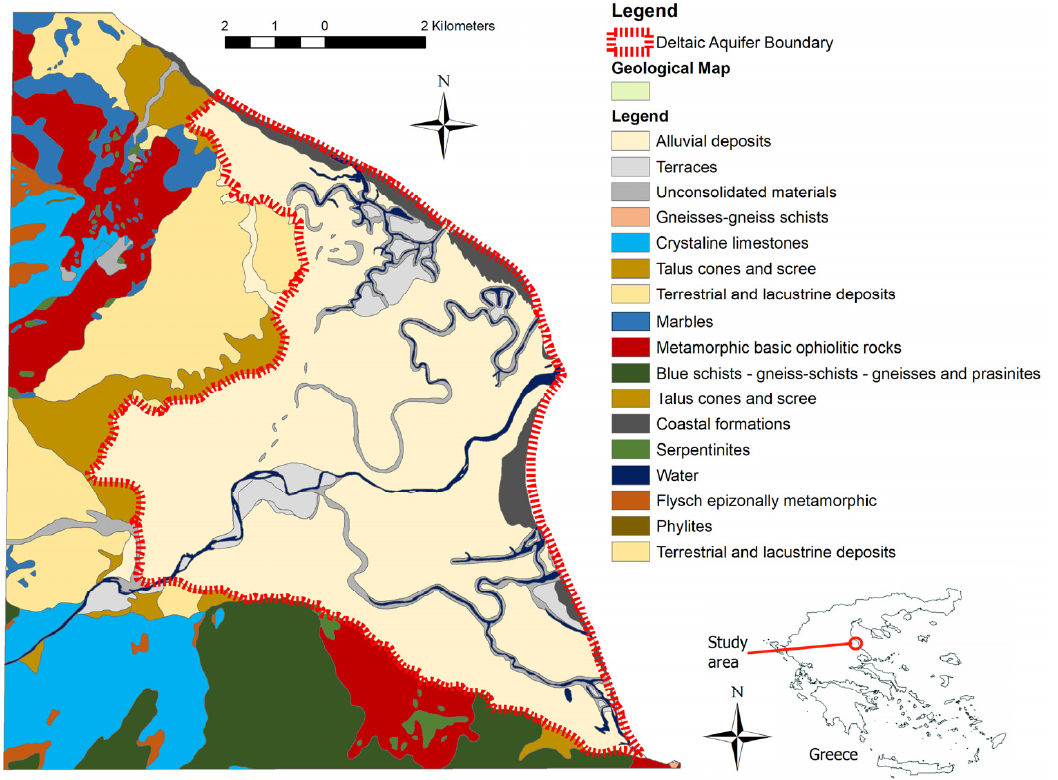
Figure 1. Location and geological map [29] of the study area.